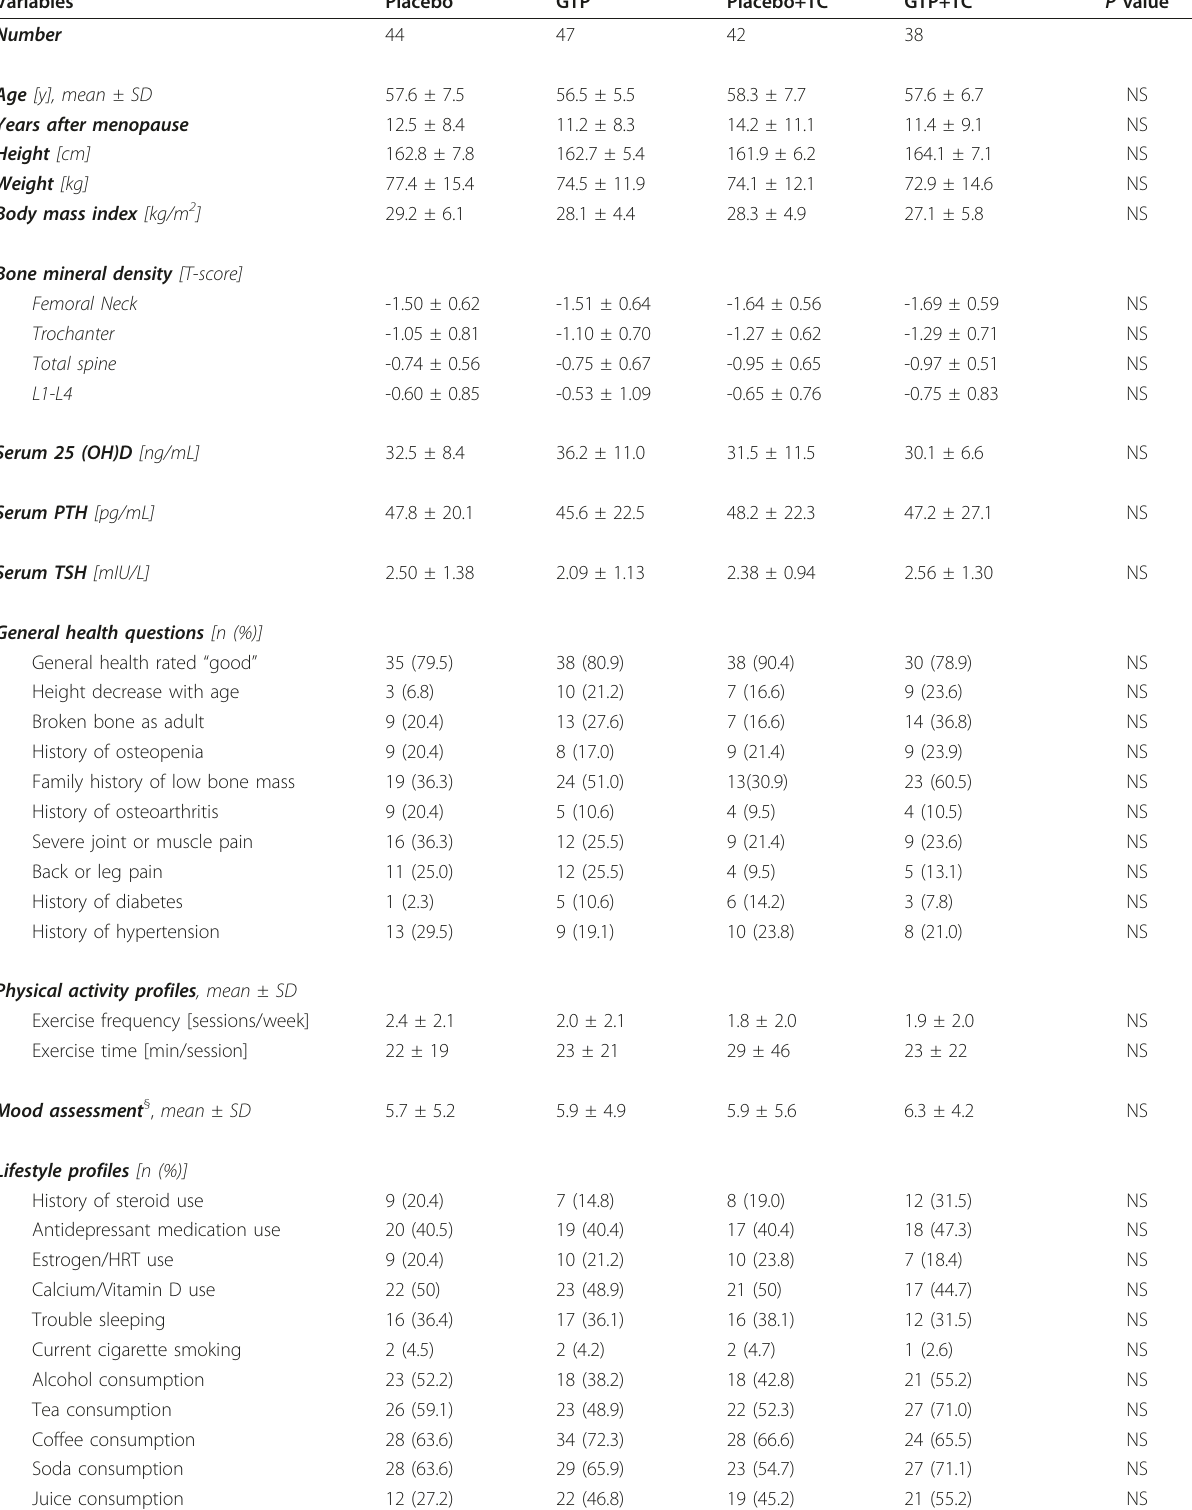
Table 1 Baseline demographic characteristics of study